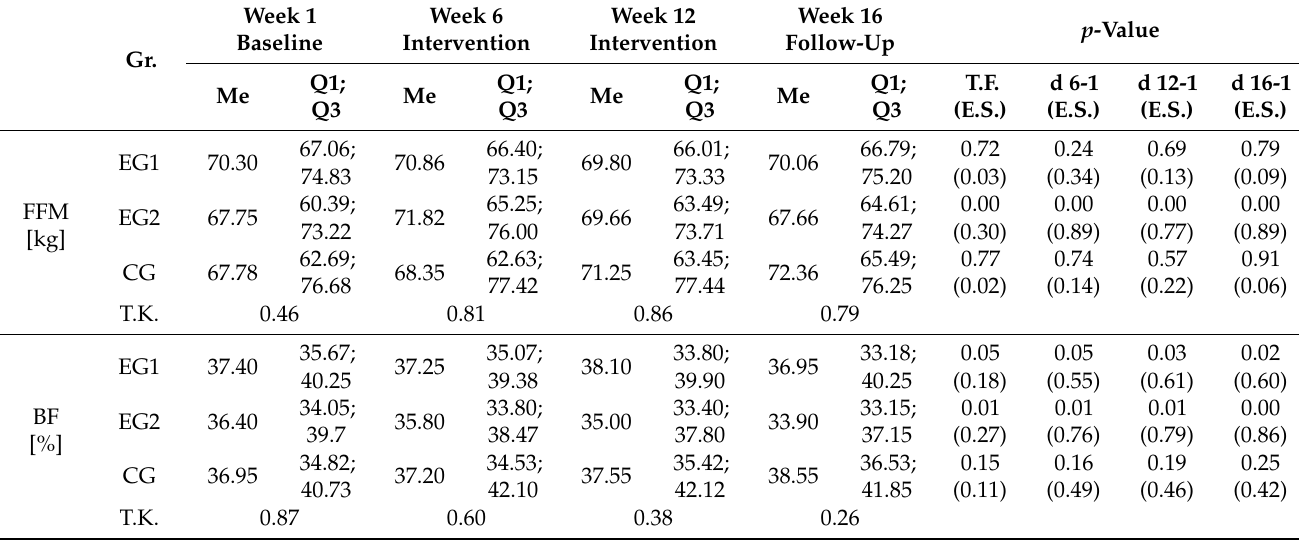
Table 4. Body composition measured using densitometry in the aerobic group (EG1), aerobic- resistance group (EG2), and control group (CG).